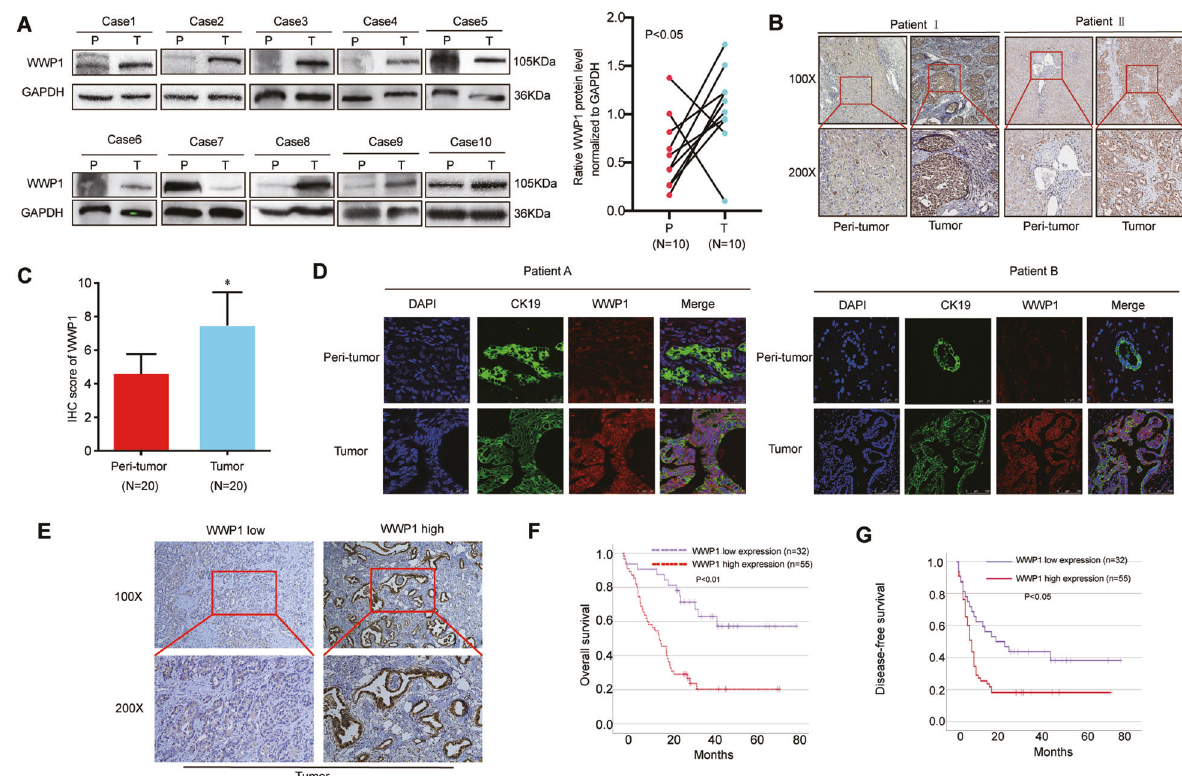
Fig. 1 WWP1 was upregulated in ICC and its high expression was related to poor prognosis. A Images of WWP1 protein levels in ICC tumor and paired adjacent non-tumor tissues by western blotting assays. P peritumoral tissues, T tumor tissue, n = 10. B Representative images of WWP1 protein levels in paraf fi n-embedded specimens performed by IHC staining. Magni fi cations, ×100 and ×200, n = 20. C The scores of WWP1 staining intensity of IHC. D Images of WWP1 expression levels in CK19-positive tumor cells and CK19-positive normal epithelial cells of adjacent non-tumor liver tissues by immuno fl uorescence staining (blue: DAPI; green: CK19; red: WWP1). E Representative IHC images of low WWP1 expression and high WWP1 expression in ICC tumor tissues. F , G Kaplan-Meier survival analyses were performed to detect the effect of WWP1 on overall survival ( F ) or disease-free survival ( G ). P is based on the log-rank test. ICC intrahepatic cholangiocarcinoma, IHC immunohistochemistry. * P <